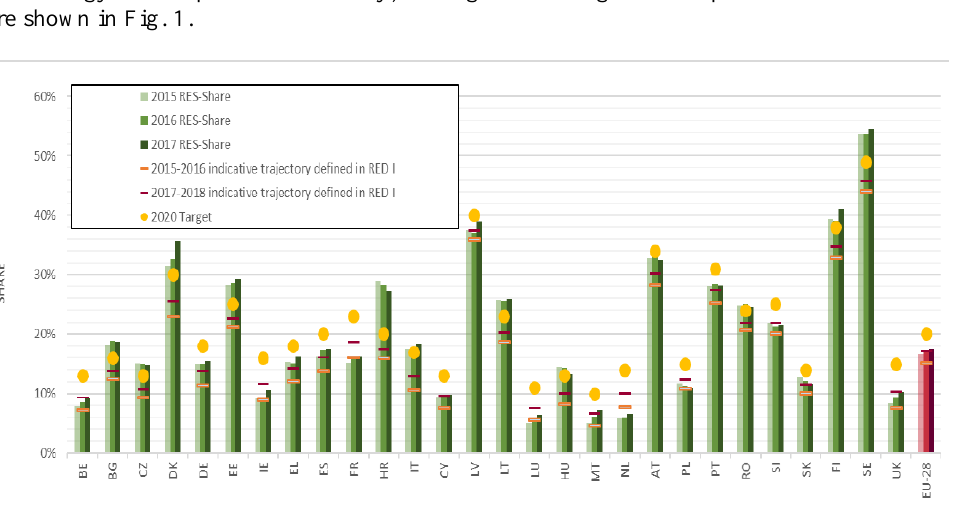
Fig. 1. EU and Member States renewable energy shares and trajectories set in gross final energy consumption